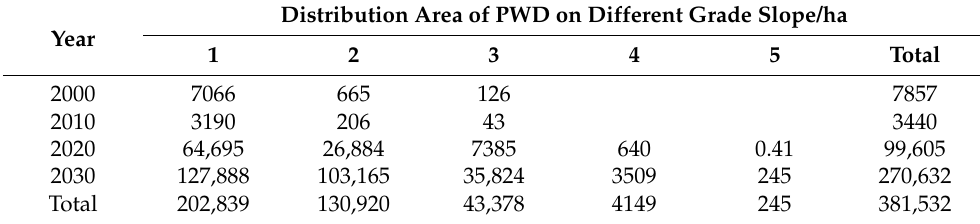
Table 4. Distribution area of PWD along slope gradient in different years.